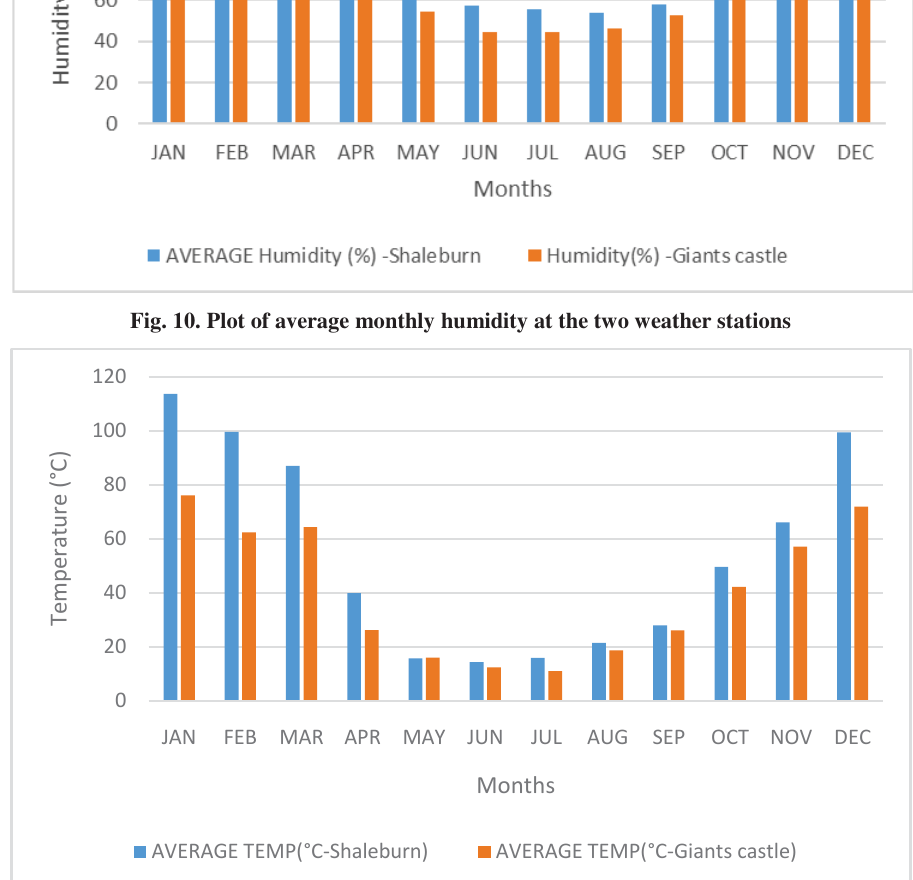
Fig. 11. Plot of average monthly temperature at the two weather